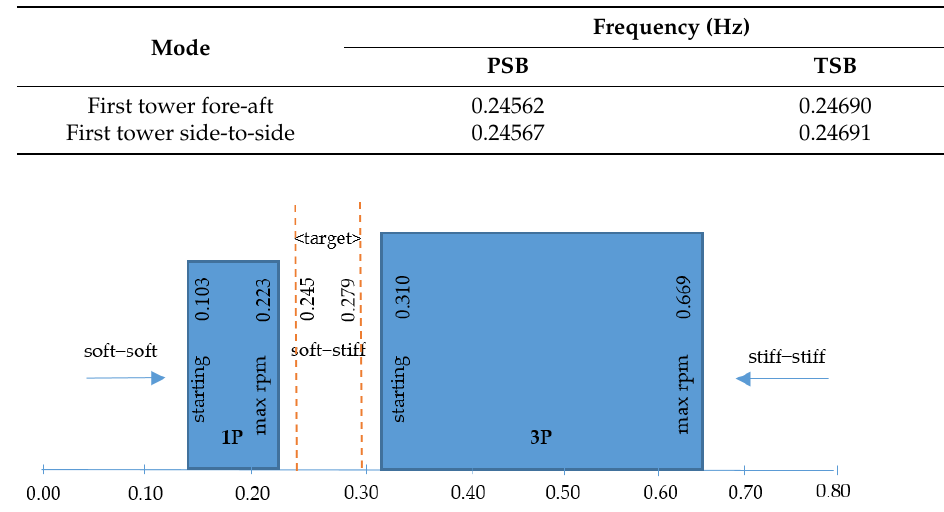
Figure 15. Design ranges for the fundamental frequency of 5.5 MW capacity turbine.